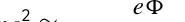
the accelerating voltage, while the solid line (a circle) shows the surface for show the surfaces for